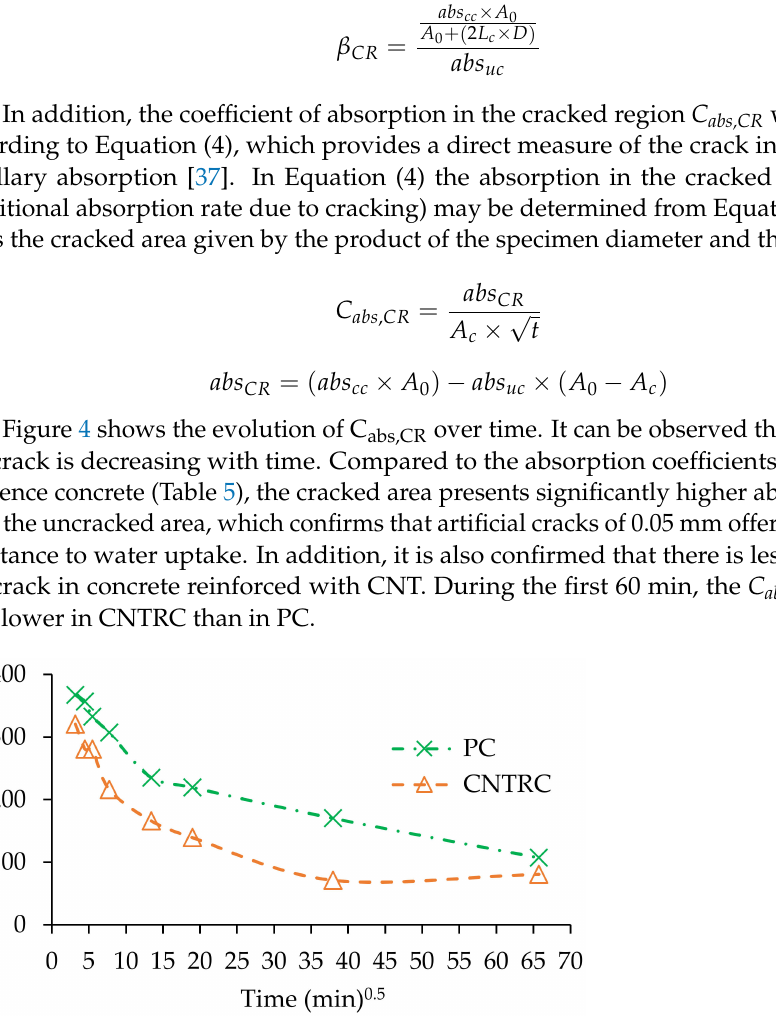
Figure 4. Absorption coefficient in the cracked area, C abs,CR , over